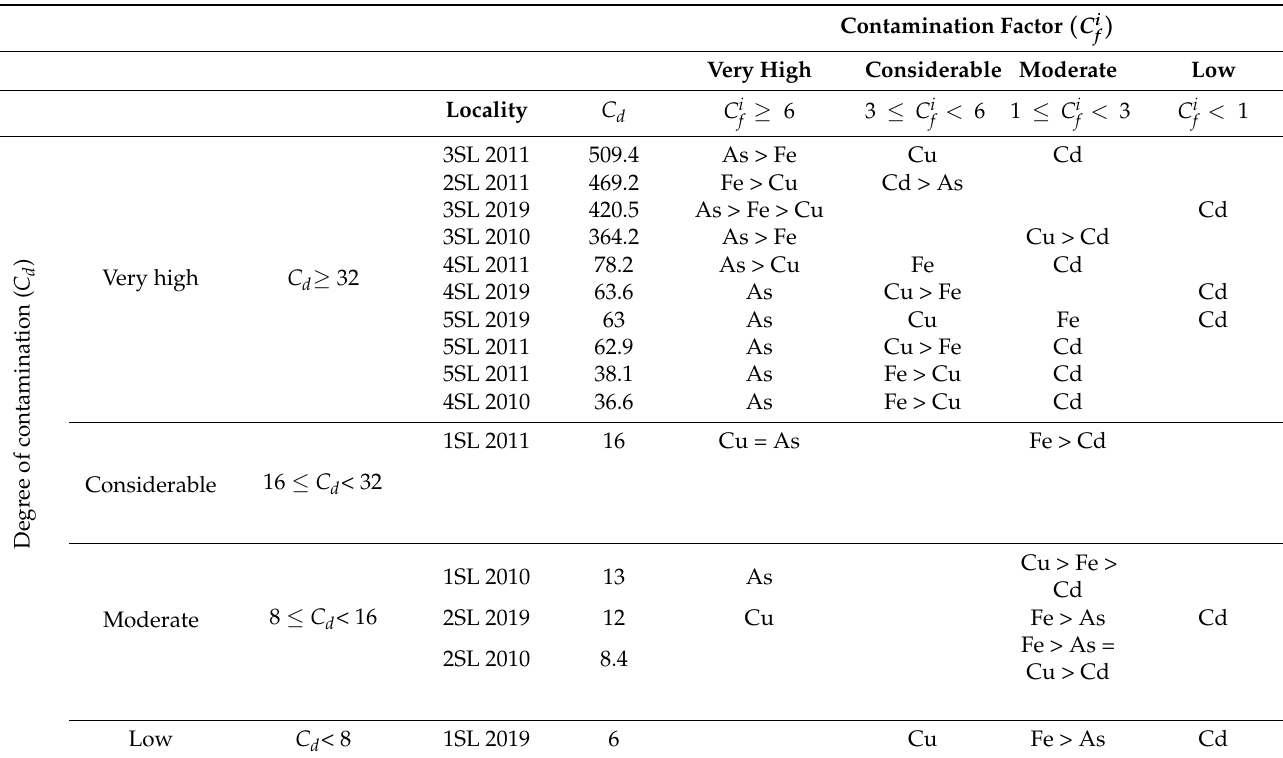
Table 3. Ranking order of water contamination of the investigated locality according to the C d value and the sequence of the contamination factors ( C i f